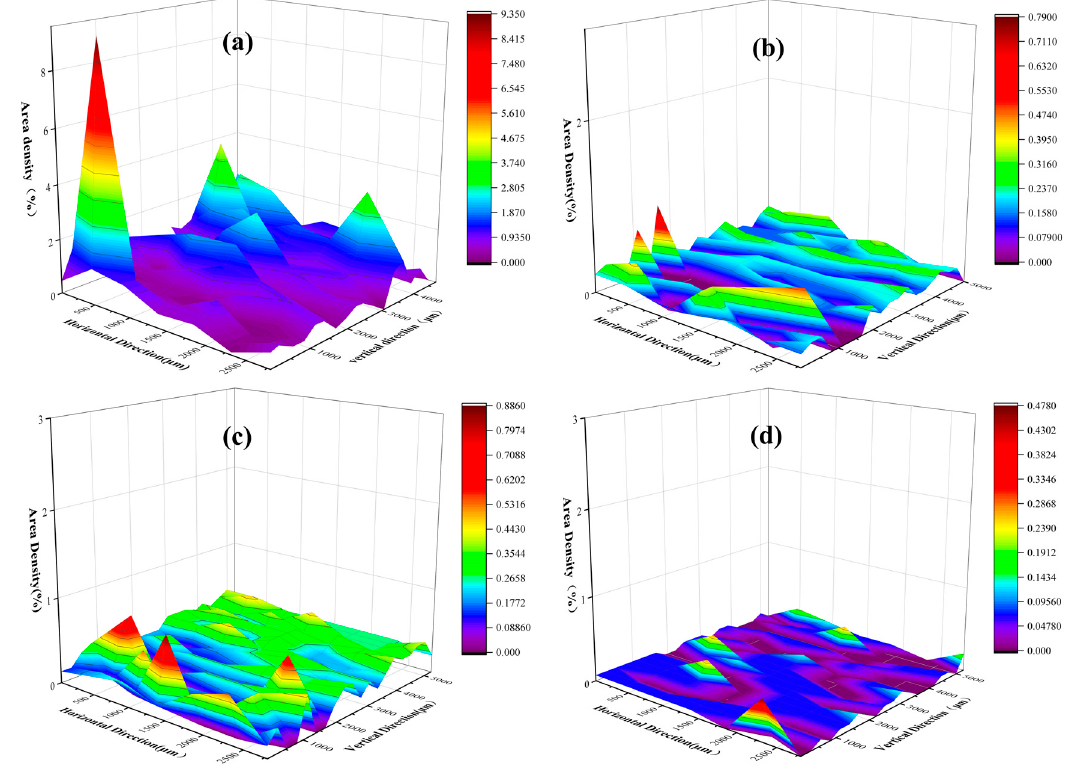
Figure 4. Change rule of inclusion area density distribution before and after dearsenication treat- ment of electrode steel. ( a ) is the area density distribution of inclusions in electrode steel before dearsenication; ( b – d ) is the area density distribution of inclusions after dearsenication treatment with ferro-calcium alloy, calcium–aluminum alloy and calcium–silicon alloy, respectively.